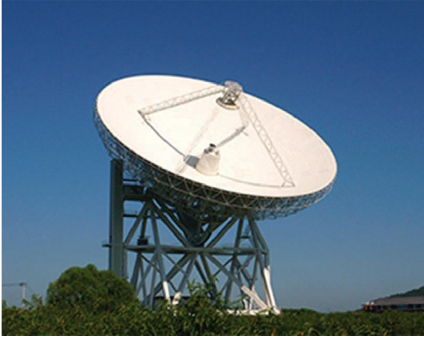
Figure 5: Tianma 65m radio telescope